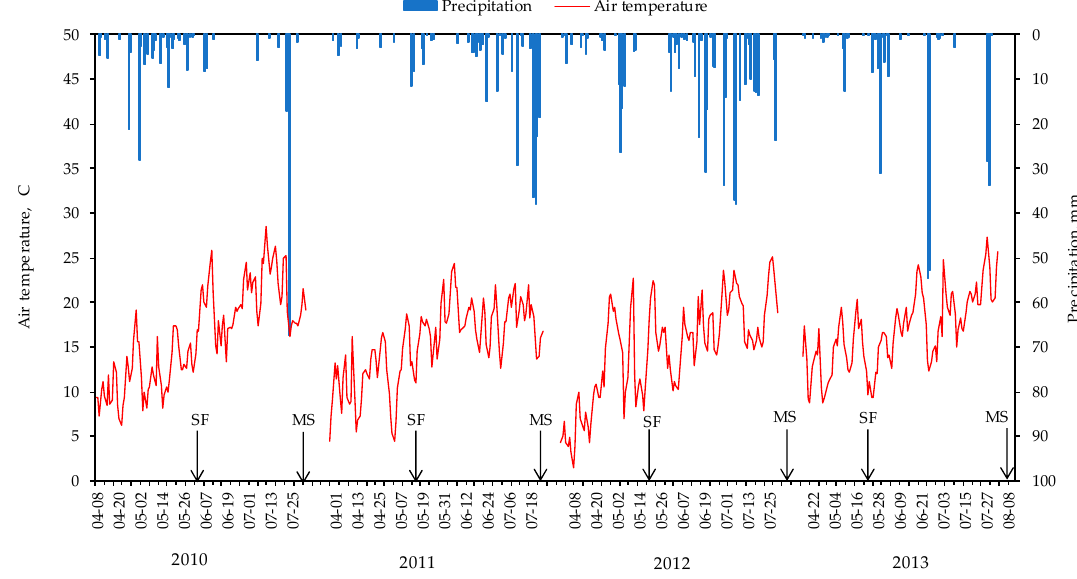
Figure 1. Mean daily air temperature and precipitation during 2010–2013 growing seasons of faba bean. Key growth stages: SF, start of flowering; MS, mature seeds (harvest).